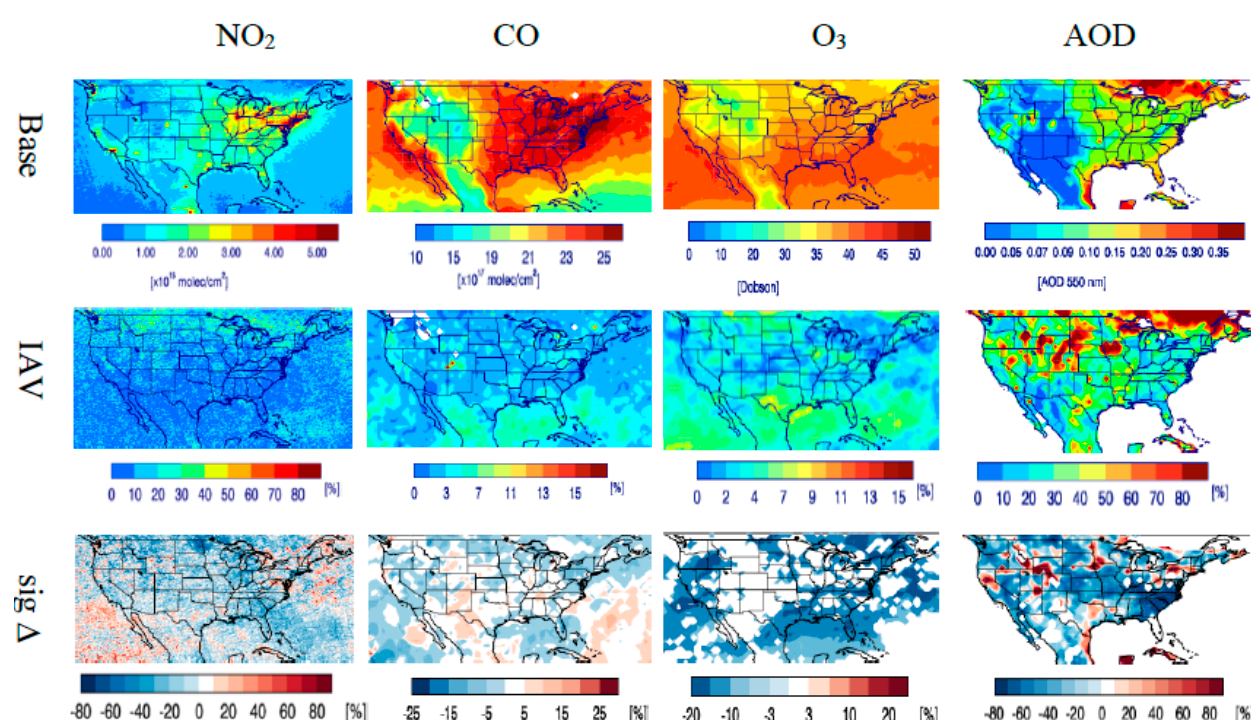
Figure 3. Top panel: Mean pollutant levels during the base period (Base); Middle panel: detrended Interannual Variability (IAV) of the base period; Bottom panel: Significant relative change ( sig ∆ ) during the lockdown period of the COVID-19 pandemic. Blank areas in the last row ( sig ∆ ) refers to insignificant differences.